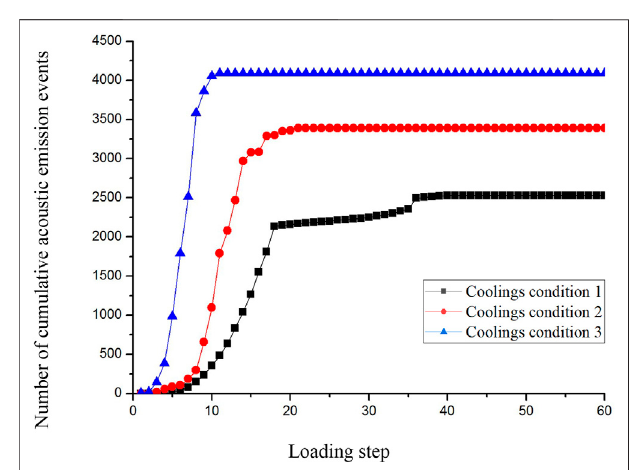
FIGURE 5 | Comparison of cumulative AE hits of three cooling